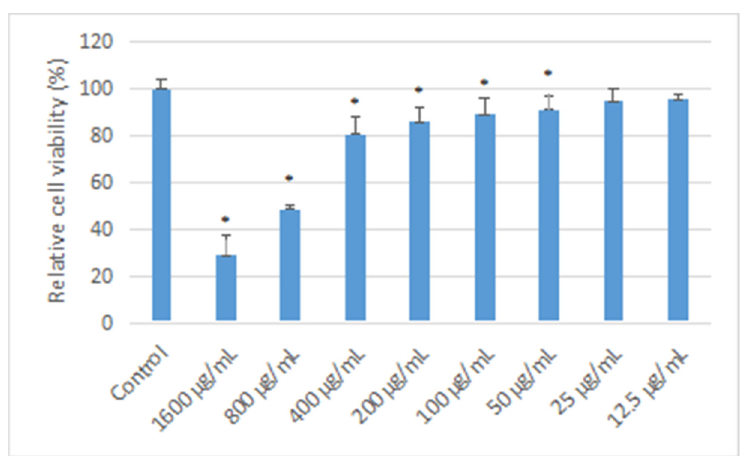
Figure 6. Effect of OF/PVP/PVA hydrogels on the cell viability of CAL-27 OF/PVP/PVA hydrogels with different concentrations of osmanthus extract were co-cultured with CAL-27 cells for 24 h, and cell viability was detected by MTT assay. *: p < 0.05 compared with control